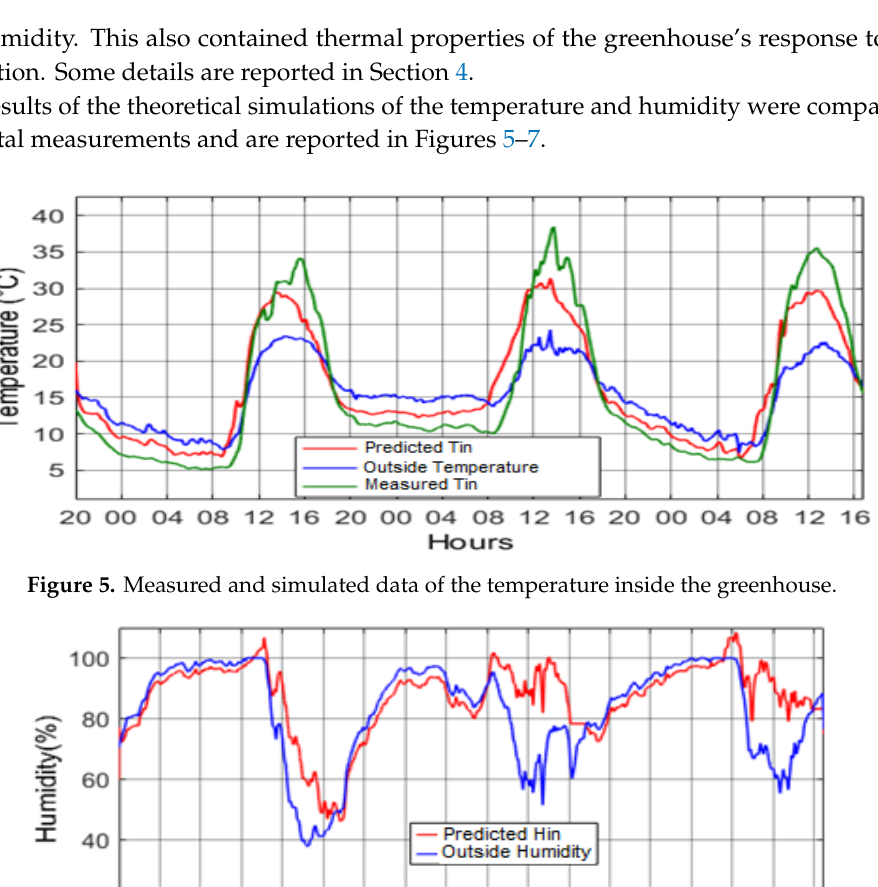
Figure 5. Measured and simulated data of the temperature inside the greenhouse.